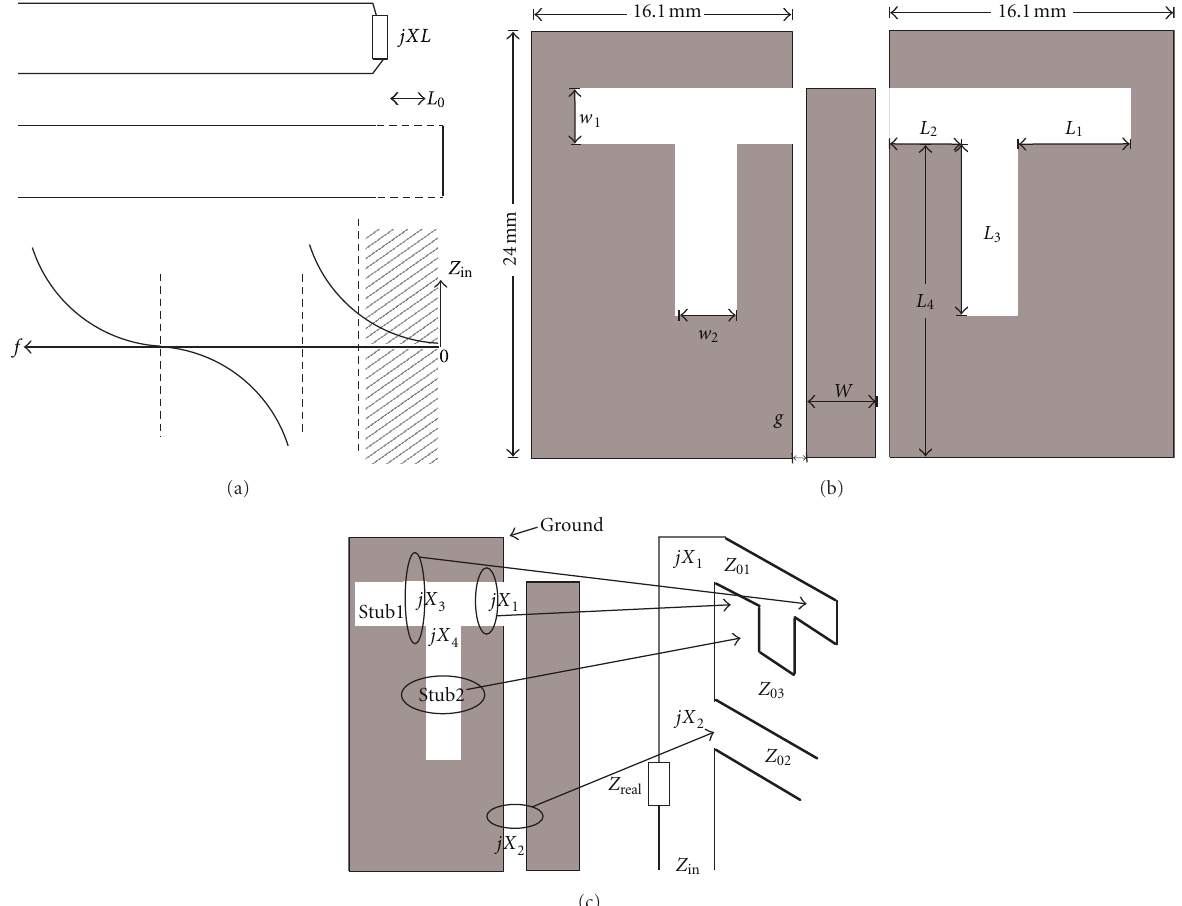
Figure 3: (a) The impedance of purely reactive loaded transmission line. (b) The geometry of antenna 2 and (c) The equivalent transmission line circuits for antenna 2.